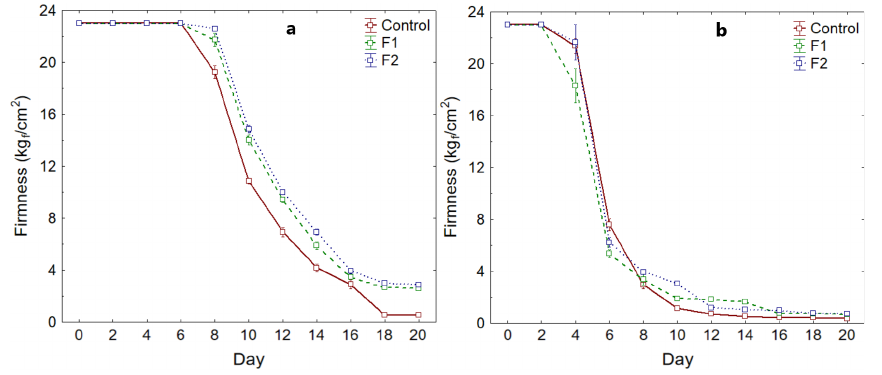
Figure 9. Firmness variation, ( a ) Hass variety, ( b ) Fuerte variety.